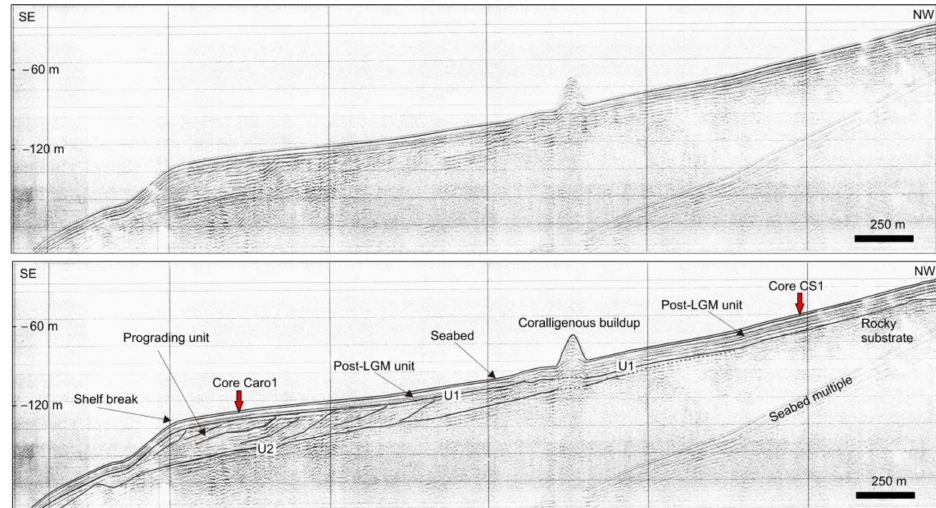
Figure 3. Uninterpreted (upper panel) and interpreted (lower panel) sparker seismic profile (A-A1 in Figure 1b) across the western Pontine shelf with an indication of location of sediment cores CS1 and Caro1